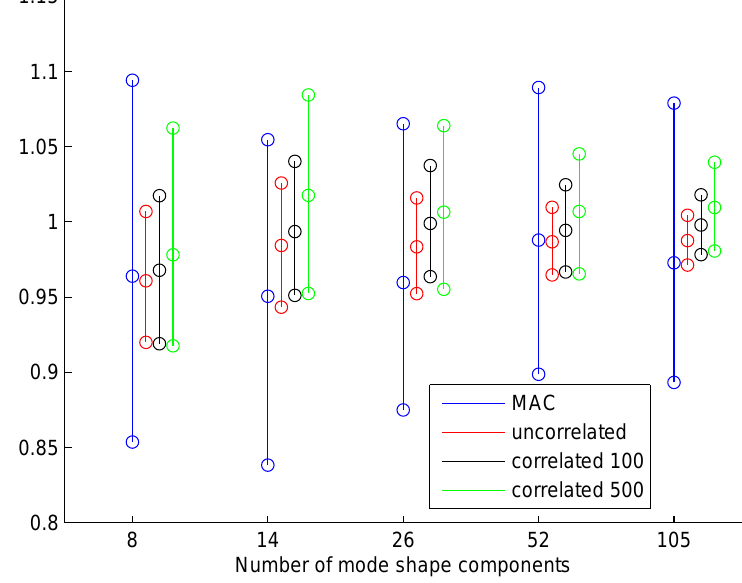
Figure 8. Pier parameter posterior uncertainty versus number of sensors. Description of curves as in Figure